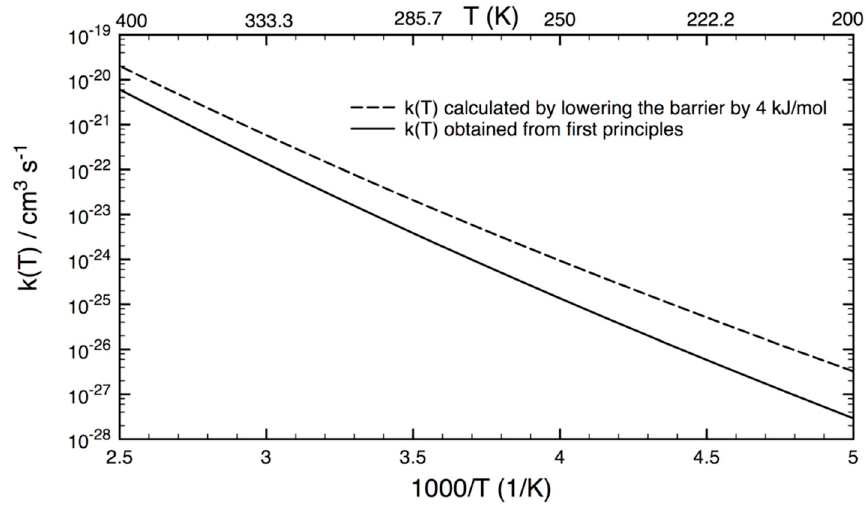
Figure 2. Calculated rate constants (cm 3 s − 1 ) of the title reaction in the atmospheric temperature range of 200 to 400 K. The solid line represents the results from first principles while the dashed line shows the results obtained when lowering the barrier height by 4 kJ mol − 1 .